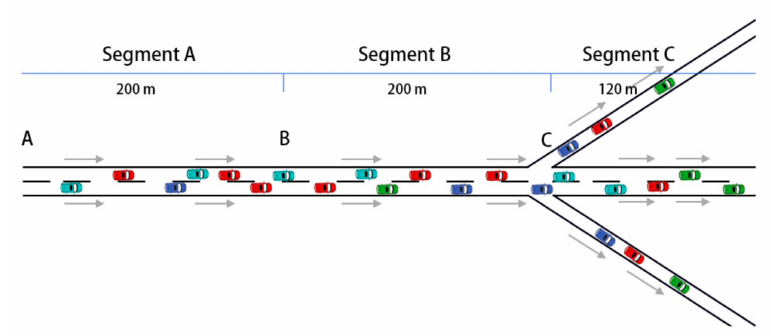
Figure 1. Road segments